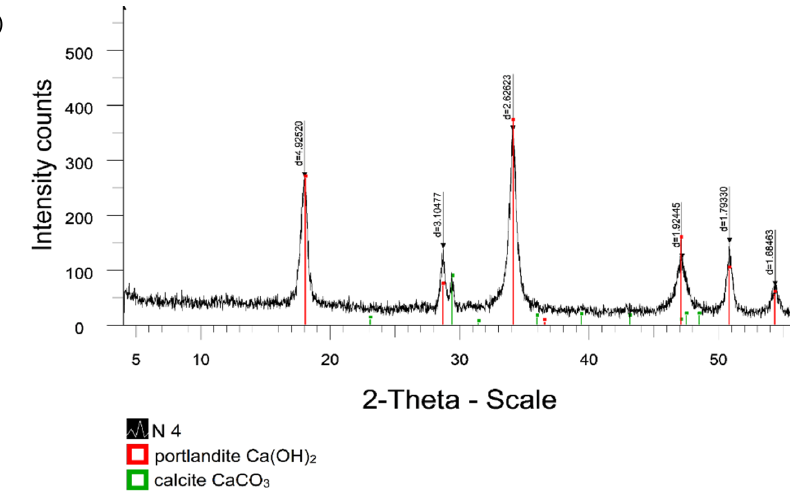
Figure 5. XRD analyses of ( a ) RM, ( b ) BFS, ( c ) NL, and ( d ) LPW.